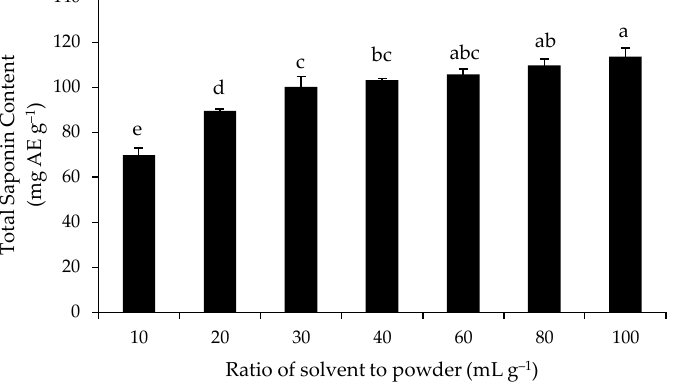
Figure 3. Effect of the ethanol to powder ratio on the TSC of the full-fat Gac seed kernel powder measured using MAE. The values are the means of three replicates for each extraction and columns not sharing the same superscript letter are significantly different at p < 0.05.